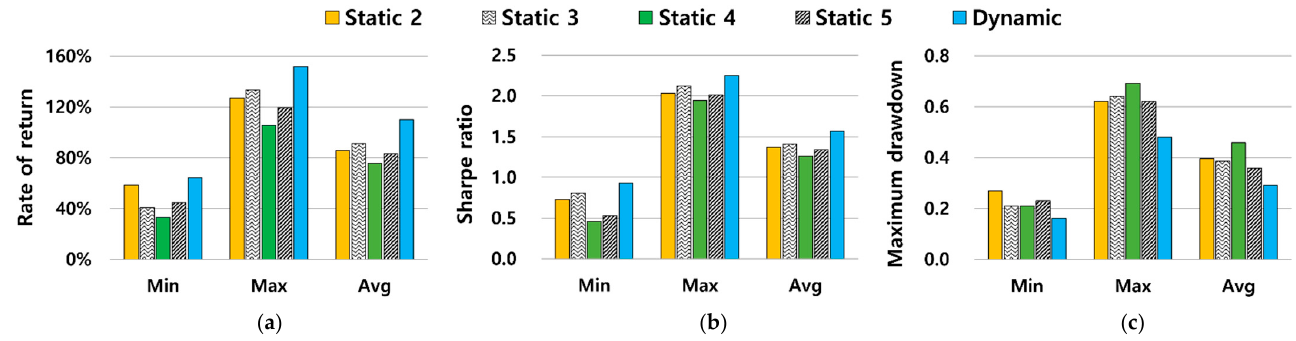
Figure 14. Comparison of static and dynamic delays. ( a ) Rate of return. ( b ) Sharpe ratio. ( c ) Maximum drawdown.